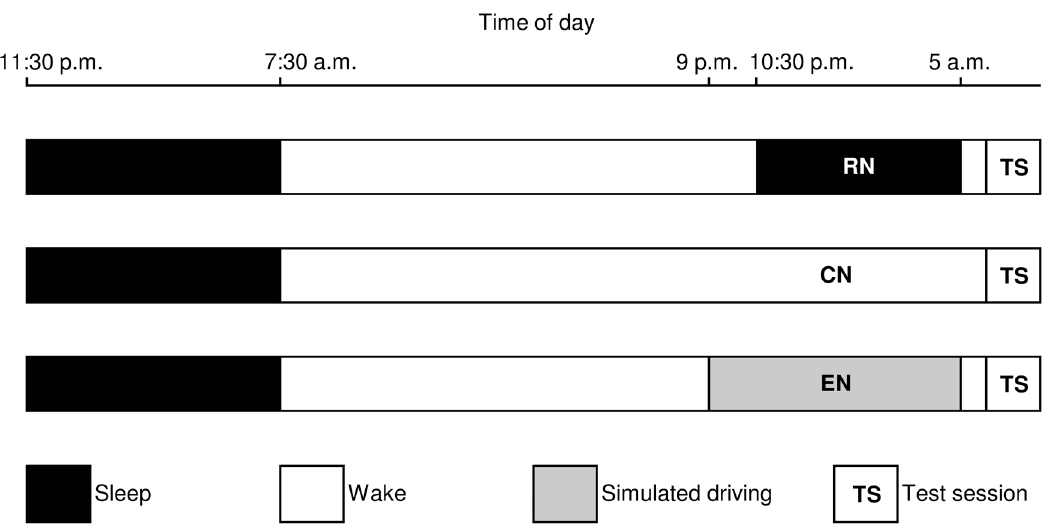
Figure 1. Design of the experimental protocol. The sleep-wake periods and the three test sessions performed after a reference night (RN), a control night (CN), and an experimental night (EN) are shown.